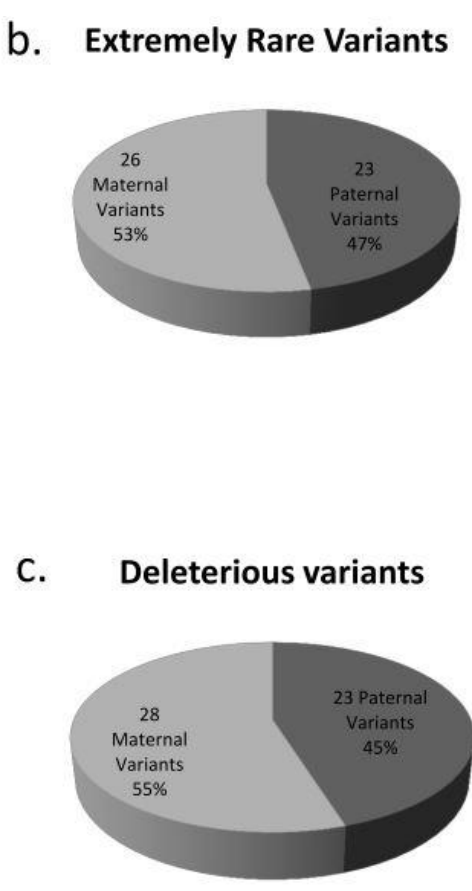
Figure 1. Graphic representation of segregation analysis data on all 101 inherited variants ( a ). Graphic representation of segregation analysis data on inherited extremely rare variants ( b ). Graphic representation of segregation analysis data on inherited deleterious variants ( c ).